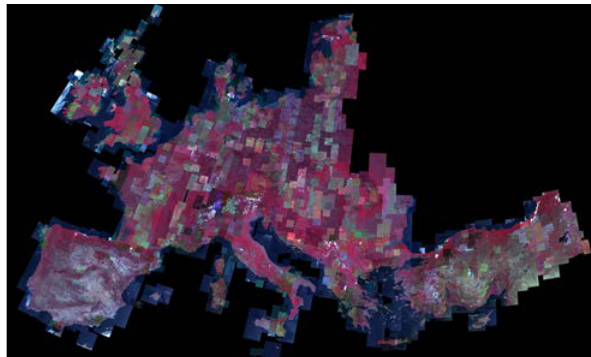
Figure 5 Example of orthorectified products derived from Spot 4 HRVIR, Spot 5 HRG and IRS-P6 Liss III data using automatically extracted GCP information from reference images for sensor model refinement. The overall geometric accuracy w.r.t. the reference is ~10m RMSE